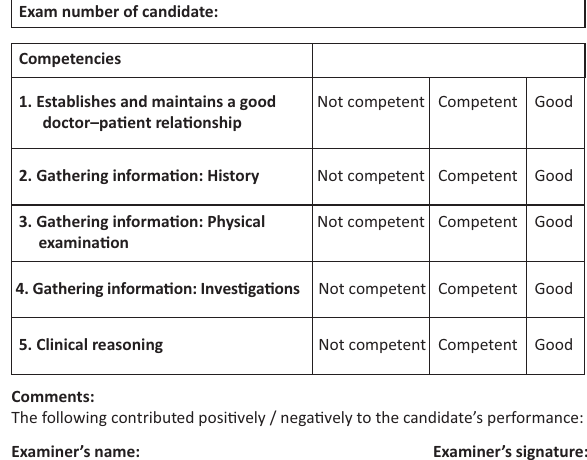
FIGURE 2: Marking template for consultation